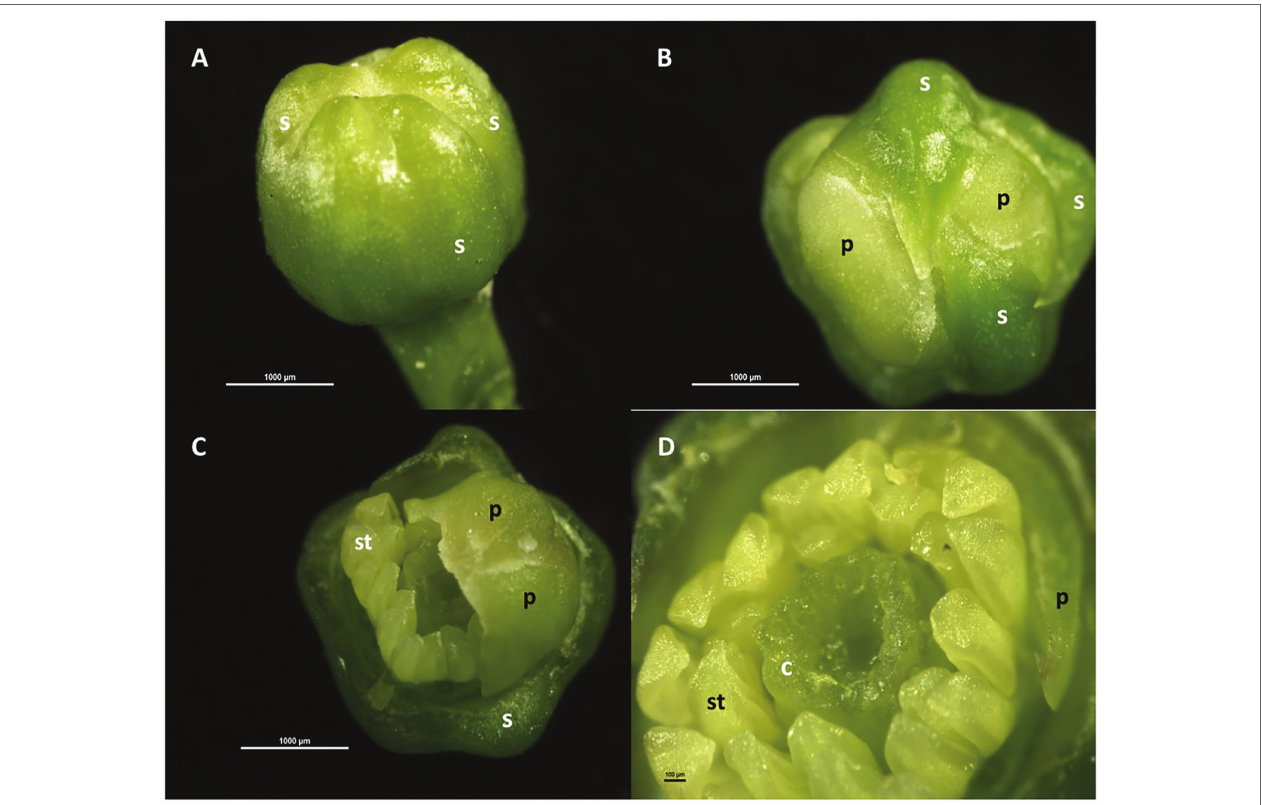
FIGURE 1 | Floral organogenesis in Citrus sinensis . (A) Floral bud with sepals and petals beneath; (B) floral bud with two sepals removed, showing whorl of petal primordia; (C) floral bud with sepals and three petals removed, showing whorl of stamen primordia; (D) floral bud with sepals and petals removed, showing whorls of stamen primordia and carpels initiating. c: carpel, p: petal, s: sepal; st: